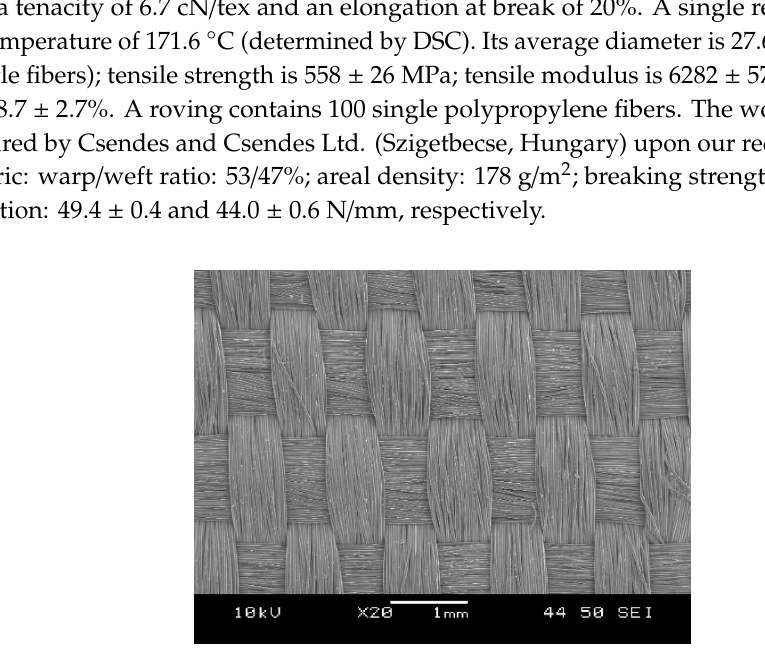
Figure 1. Scanning electron microscopic image of the reinforcing woven fabric.